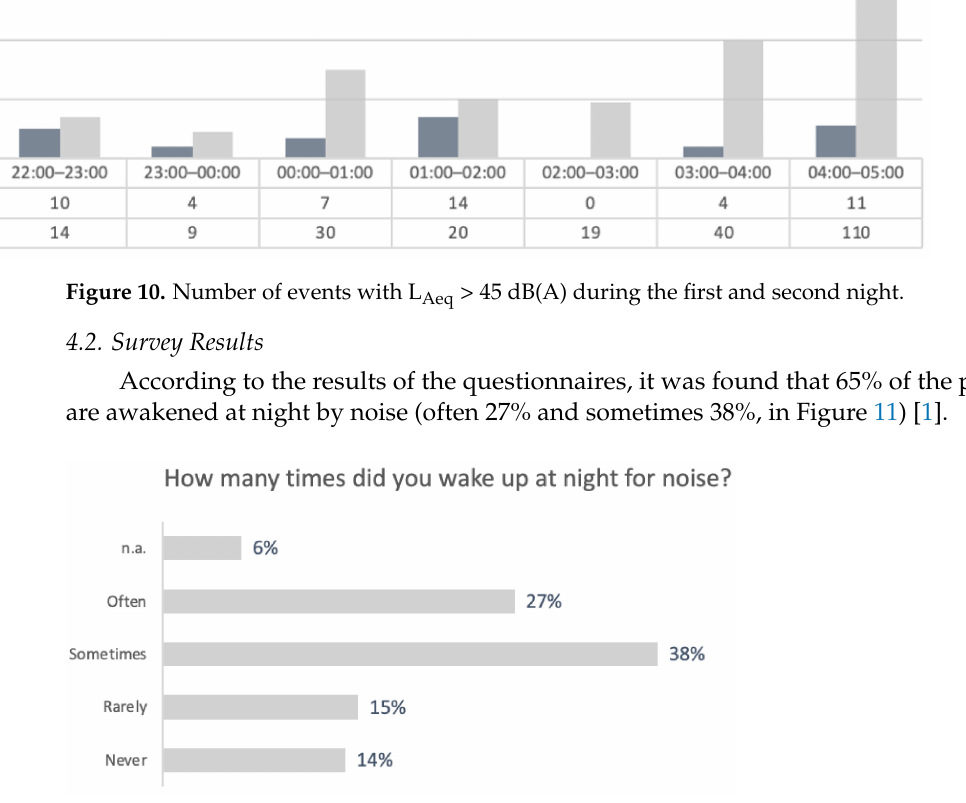
Figure 11. Results of the survey: “How many times did you wake up at night for noise?”.